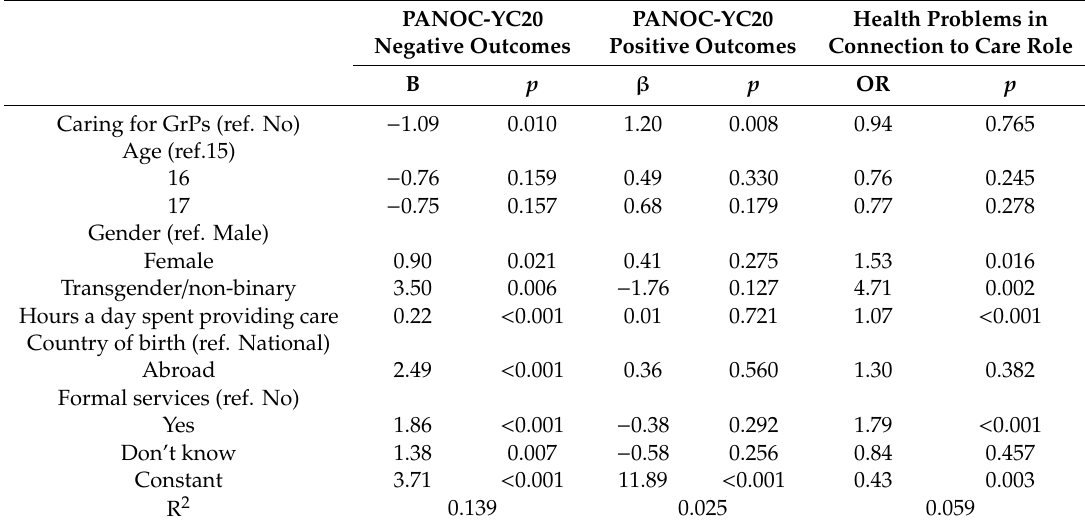
Table 3. Exposure factors to positive and negative caregiving outcomes and health problems among AYCs of OCRs and AYCs of GrPs (n = 817). PANOC-YC20 PANOC-YC20 Health Problems in Negative Outcomes Positive Outcomes Connection to Care Role B p β p OR p Caring for GrPs (ref. No) − 1.09 0.010 1.20 0.008 0.94 0.765 Age (ref.15) 16 − 0.76 0.159 0.49 0.330 0.76 0.245 17 − 0.75 0.157 0.68 0.179 0.77 0.278 Gender (ref. Male) Female 0.90 0.021 0.41 0.275 1.53 0.016 Transgender / non-binary 3.50 0.006 − 1.76 0.127 4.71 0.002 0.01 0.721 1.07 < 0.001 2.49 < 0.001 0.36 0.560 1.30 0.382 1.86 < 0.001 − 0.38 0.292 1.79 < 0.001 Don’t know 1.38 0.007 − 0.58 0.256 0.84 0.457 Constant 3.71 < 0.001 11.89 < 0.001 0.43 0.003 R 2 0.139 0.025